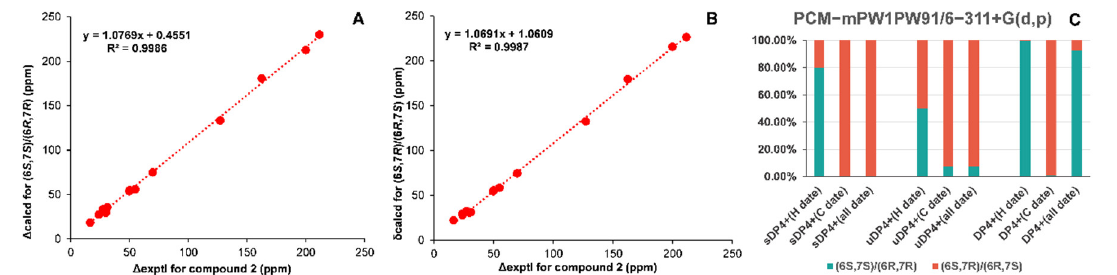
Figure 3. Comparison of the experimental and calculated NMR chemical shifts of compound 1 . ( A ) Regression analysis of experimental 13 C NMR chemical shifts of compound 1 vs. calculated 13 C NMR chemical shifts of (6 S ,7 S )/(6 R ,7 R )- 1 . ( B ) Regression analysis of experimental 13 C NMR chemical shifts of compound 1 vs. calculated 13 C NMR chemical shifts of (6 S ,7 R )/(6 R ,7 S )- 1 . ( C ) DP4+ probability for (6 S ,7 S )/(6 R ,7 R )- 1 and (6 S ,7 R )/(6 R ,7 S )- 1 at the PCM-mPW1PW91/6-311+G(d,p) level.